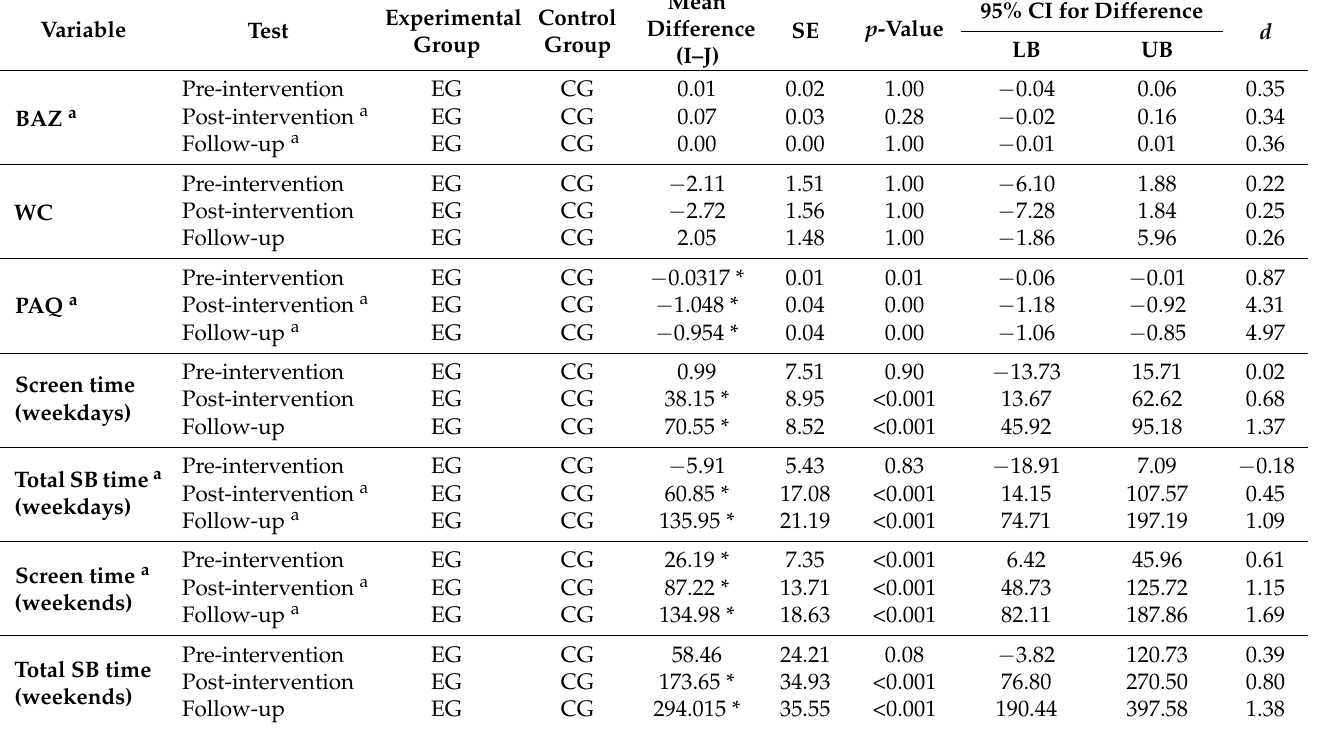
Table 4. Pairwise comparisons between both groups at three times for BMI-for-age z-score, waist circumference, physical activity, and screen time and the total sedentary behavior on weekdays and